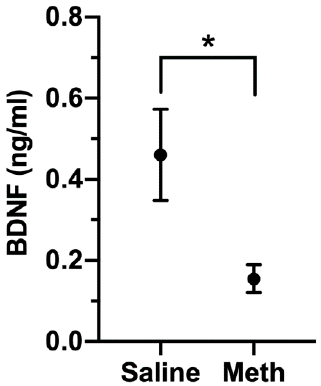
Figure 9. Plasma BDNF levels in saline ( n = 6) and meth ( n = 7) treated monkeys. One of the